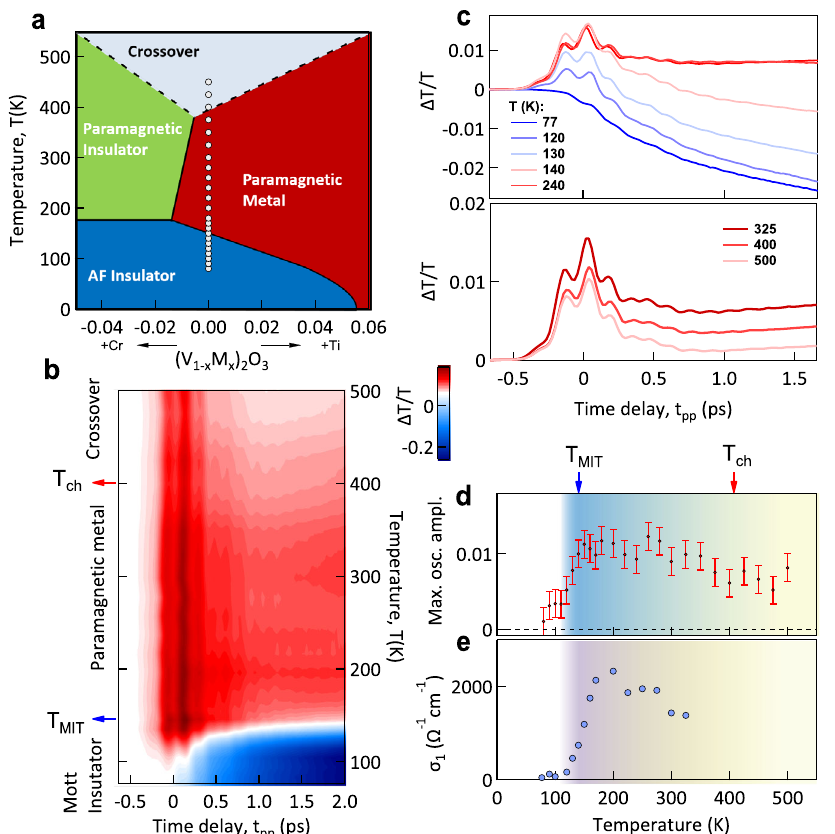
Fig. 4 Temperature evolution of the sum-frequency excitation across the insulator to metal transition. a Temperature vs doping phase diagram of V 2 O 3 according to ref. 44 . The empty circles denote the values of the temperature measured in the present work. b Temperature dependence of the THz pump induced optical transmission modulation in V 2 O 3 . When the THz pulse interacts with the insulating Mott phase, no prominent signatures of lattice oscillation are observed. T MIT indicates the metal-isulator transition temperature, while T ch is the quasiparticle coherence temperature. c Pump-probe traces at selected temperatures. d , e Temperature dependence of the maximum oscillations amplitude (Max. osc. ampl.) d , and the real part of THz optical conductivity σ 1 e of V 2 O 3 . THz optical conductivity of the V 2 O 3 fi lm as a function of temperature was measured using Fourier-transform infrared spectroscopy in the THz range (see Supplementary Note 1). The color shading of d , e divides insulating phase and metallic phase. Error bars indicate the standard deviations of the mean determined from pump-probe scan measurements with 15 acquisitions per